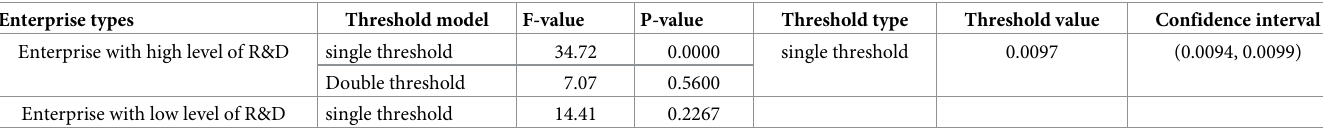
Table 5. Test result of threshold effect.